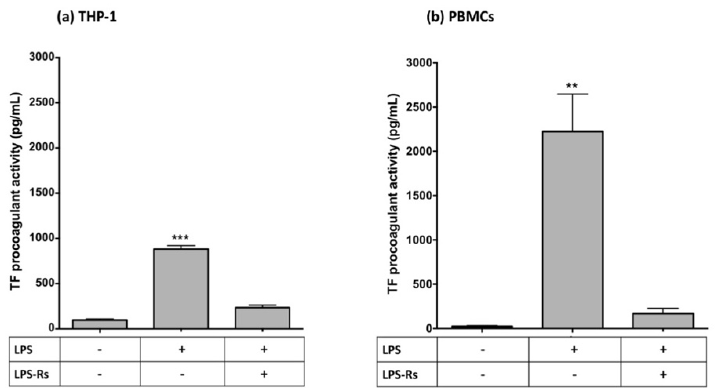
Figure 9. TF procoagulant activities measured in THP-1 ( a ) and PBMCs ( b ). Both cell lines were pre- treated with a specific TLR4 antagonist (i.e., 1 µg/mL LPS-Rs) for 30 min and subsequently stimu- lated with LPS (10 µg/mL for 4 h for THP-1 and 0.1 µg/mL for 18 h for PBMCs). Data are presented as mean ± SEM ( n = 4). *** p < 0.001 vs. the basal condition; ** p < 0.01 vs. the basal condition.